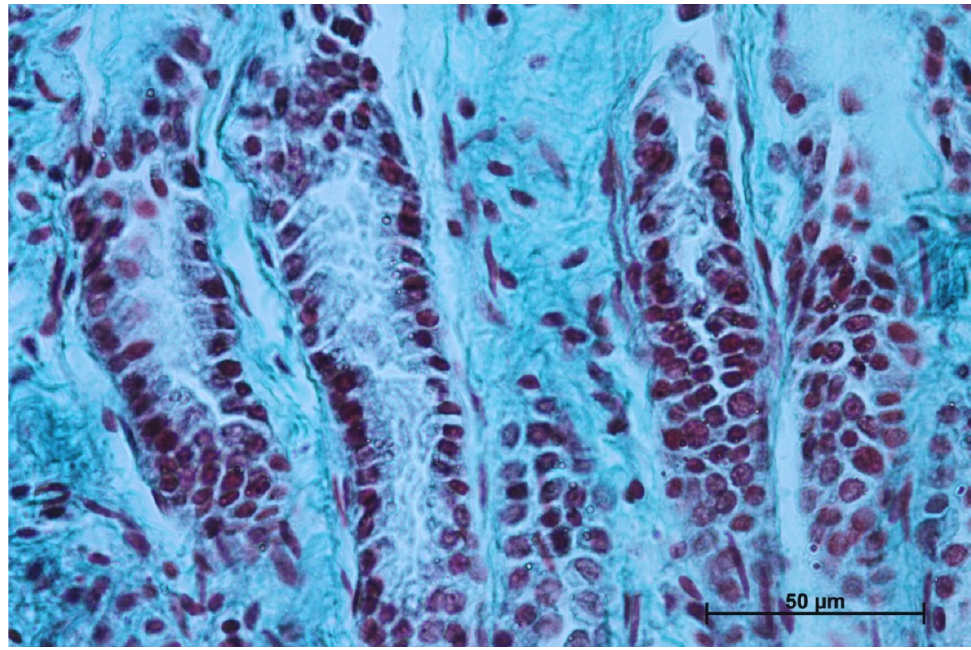
Figure 11. Body of the fundic glands with visible chief and parietal cells (Masson-Goldner staining, 63×). In contrast with the first age group, where the simple cylindrical epithelium began to protrude into the lamina propria mucosae and no specialized or histologically differen- tiated cells were observed, and the second age group, where the first parietal cells were visible, in the third age group both cell types were present. A comparison of the fundic